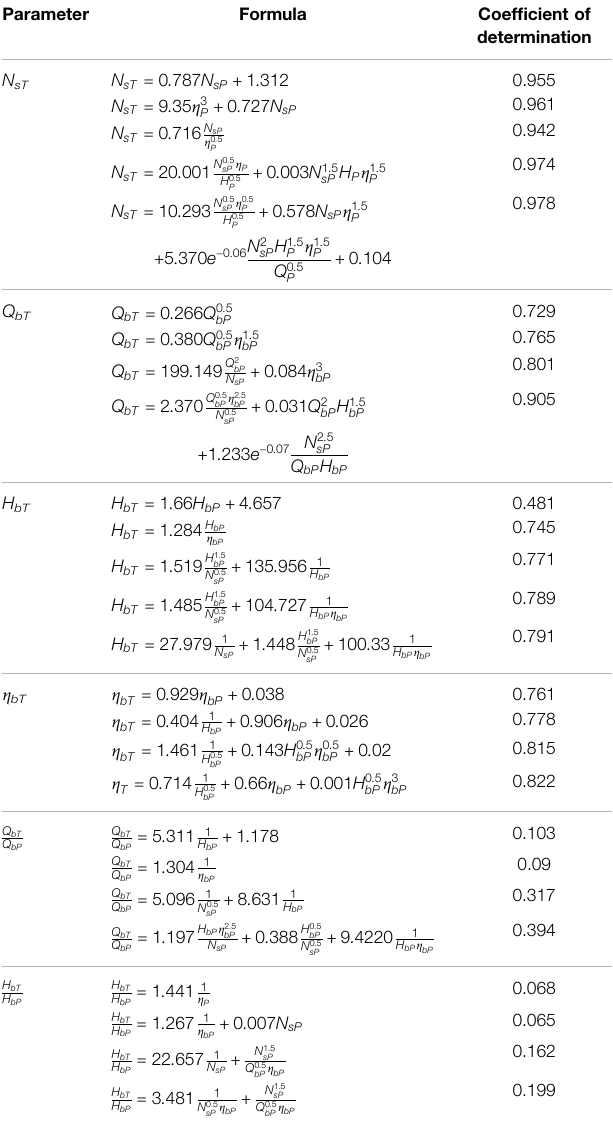
TABLE 4 | Models established by ANN – EPR algorithms (Balacco, 2018). Parameter Formula Coef fi cient of